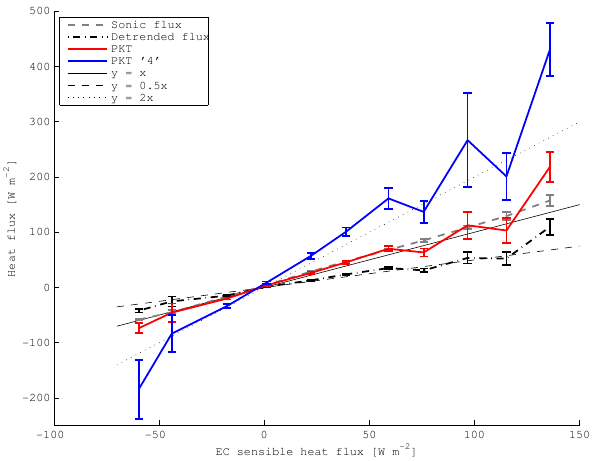
Fig. 11. Ratio of the detrended CO 2 fluxes F 0 c from wetA and wetB as used for the PKT correction to the CO 2 flux calculated from dryB (purple + , blue + ). Two values of the same sample interval are con- nected with a grey line; the factor β = as in Eq. (7), calculated from the latent heat flux and relative hu- midity, as measured by wetB , (grey • ). The PKT-corrected fluxes are the product of F 0 c and β . The black lines indicate the ratios zero and